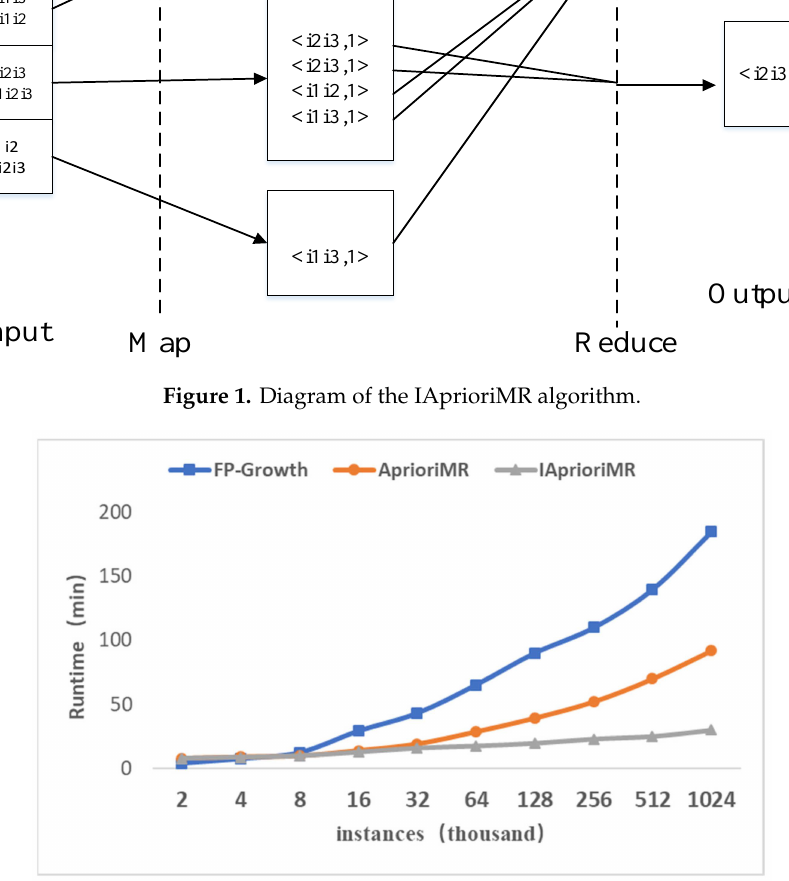
Figure 2. Runtime of di ff erent algorithms on the dataset and a number of instances that varies from 2000 to 1,024,000.